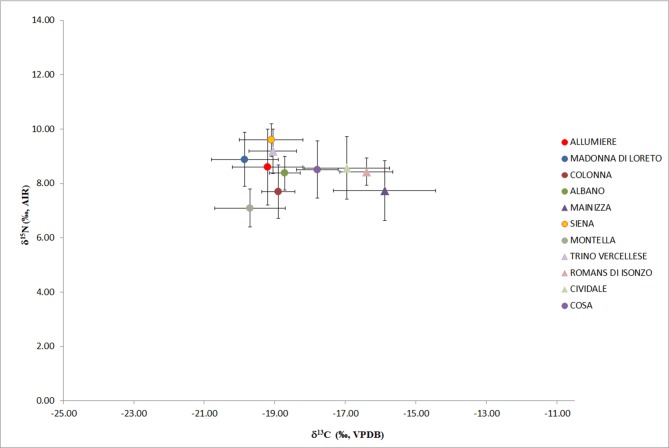
Plot of carbon vs nitrogen mean isotopic values and error bars represent ±1σ for human remains from Allumiere and the other Medieval Italian sites.Triangles represent the north Italian populations and circles the central Italian populations. Trino Vercellese (Piedmont) [92]; Pava Piene Siena (Tuscany) [93]; Piazza Madonna di Loreto (Rome) [94]; Cividale, Romans d'Isonzo and Mainizza (Friuli-Venezia Giulia) [95]; Cosa Grosseto (Tuscany) [96]; Albano Laziale Rome (Lazio) [97]; Montella Avellino (Campania) [98]; Colonna Rome (Lazio) [99].